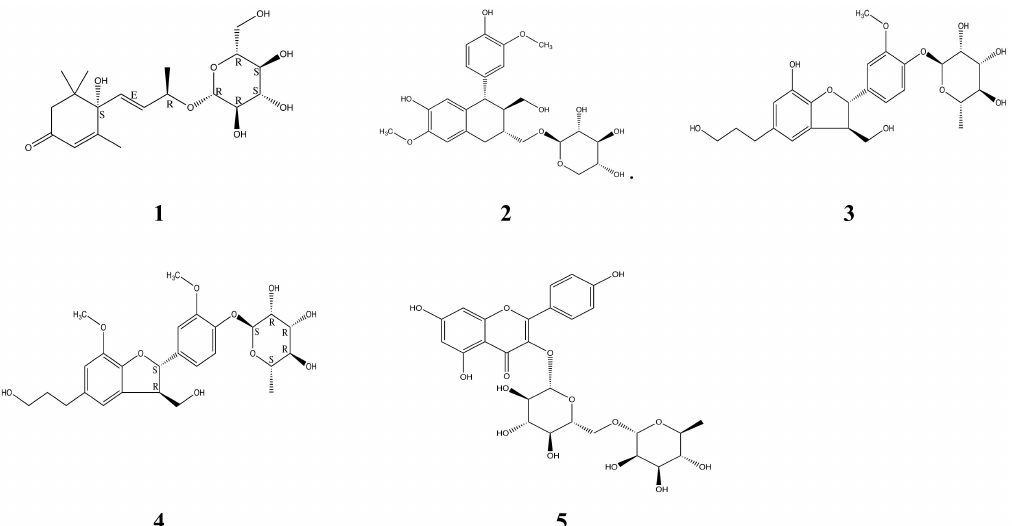
Figure 2. Chemical structures of the compounds isolated from NA. NA (1.9 kg) was fractioned using various organic chemicals and columns as described in “Materials and Methods”. Finally, five single components were identified from NA, and then the structure of each component was analyzed using ESI–MS, 1 H-NMR, and 13 C-NMR spectra. The inhibitory effects on the expression of AT1 of each fraction separated with organic chemicals were determined (data not shown). Structures of ( 1 ), ( 2 ), ( 3 ), ( 4 ), and ( 5 ) indicate roseoside, isolariciresinol 9- O - β - D -xyloside, massonianoside B, icariside E4, and nicotiflorin, respectively. The molecular formulas of the components roseoside and icariside E4, which demonstrated biological activity, re C19H30O8 (MW, 386.1941) and C26H34O10 (MW, 506.5480),